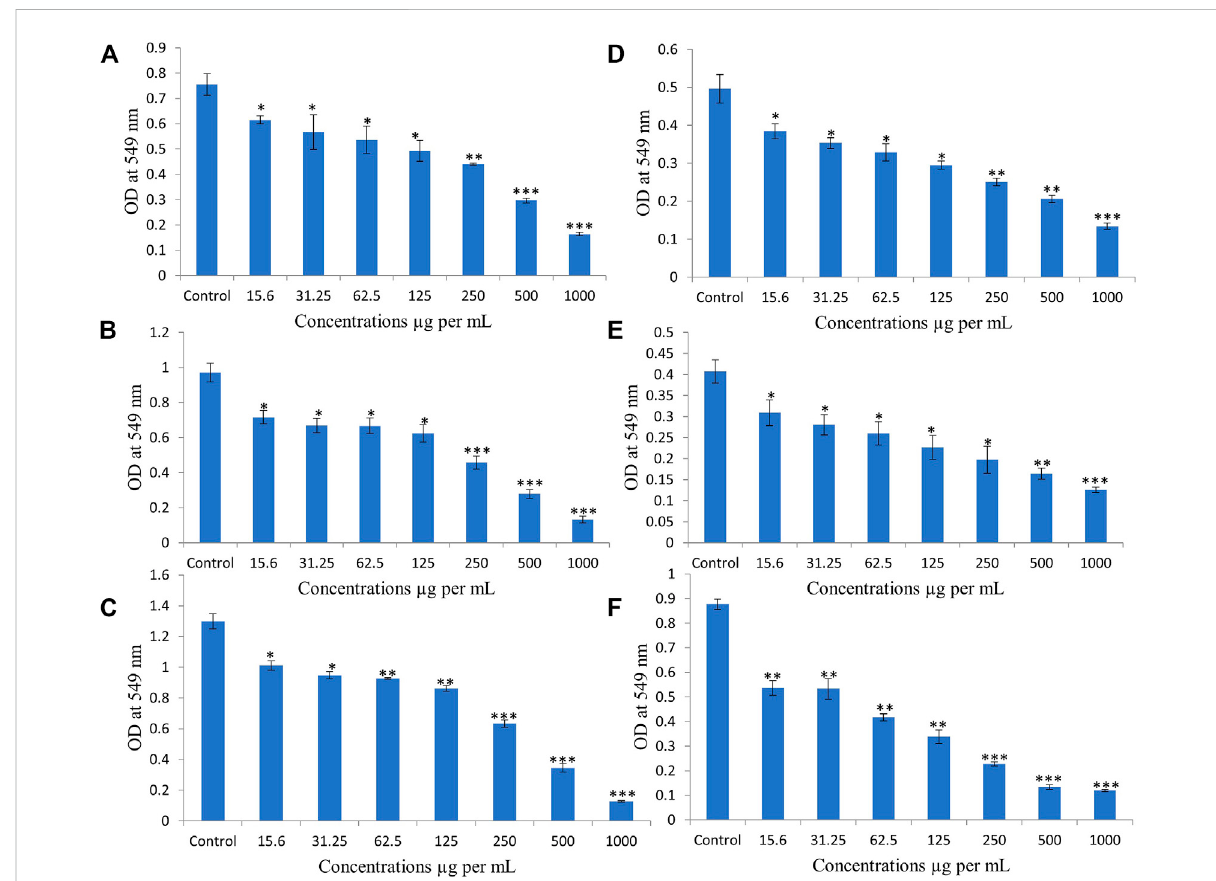
FIGURE 1 Ethanolic extract of Colligonum comosum (EECC) inhibits proliferation of two breast cancer cells, MCF-7 ( A , for 24 h; B , for 48 h; C , for 72 h) and MDA 231 ( D , 24 h; E , for 48 h; F , for 72 h). Cancer cells were treated with indicated concentrations of EECC with DMSO control for 24, 48 and 72 h followed by determination of proliferation by MTT assay, as detailed in the Materials and Methods part. * p < 0.05, ** p < 0.01, *** p < 0.0001 vs. control. Data represent mean ± SD of eight technical